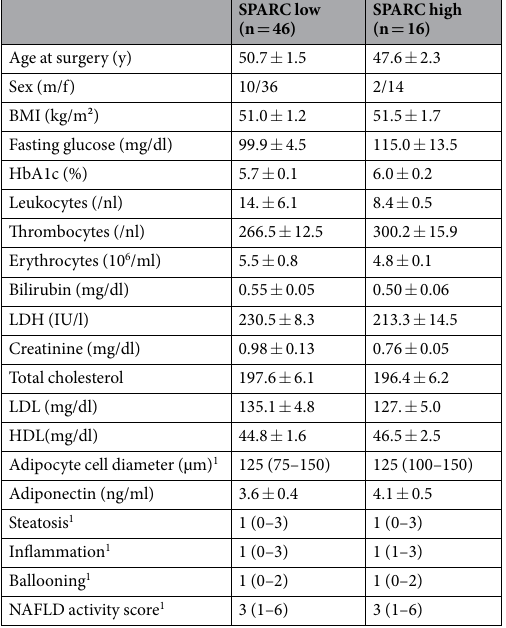
Table 1. Demographic and clinical data of obese patients separated by hepatic SPARC mRNA expression. Data is given as mean ± standard error of mean. 1 Data for these parameter is given as mean (range).